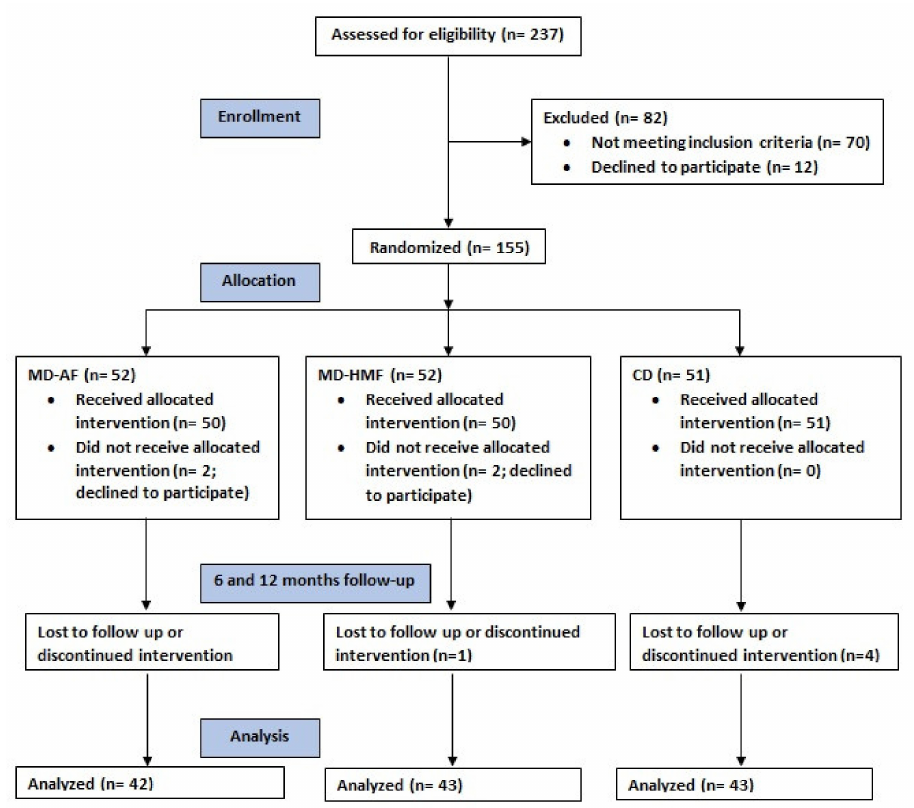
Figure 1. Flowchart of the